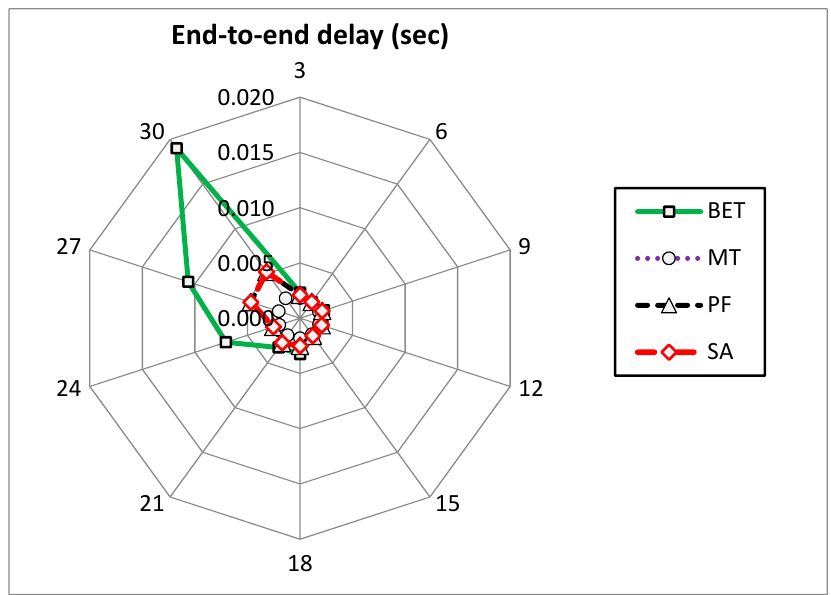
Figure 3. Average packet end-to-end delay results for near video users.